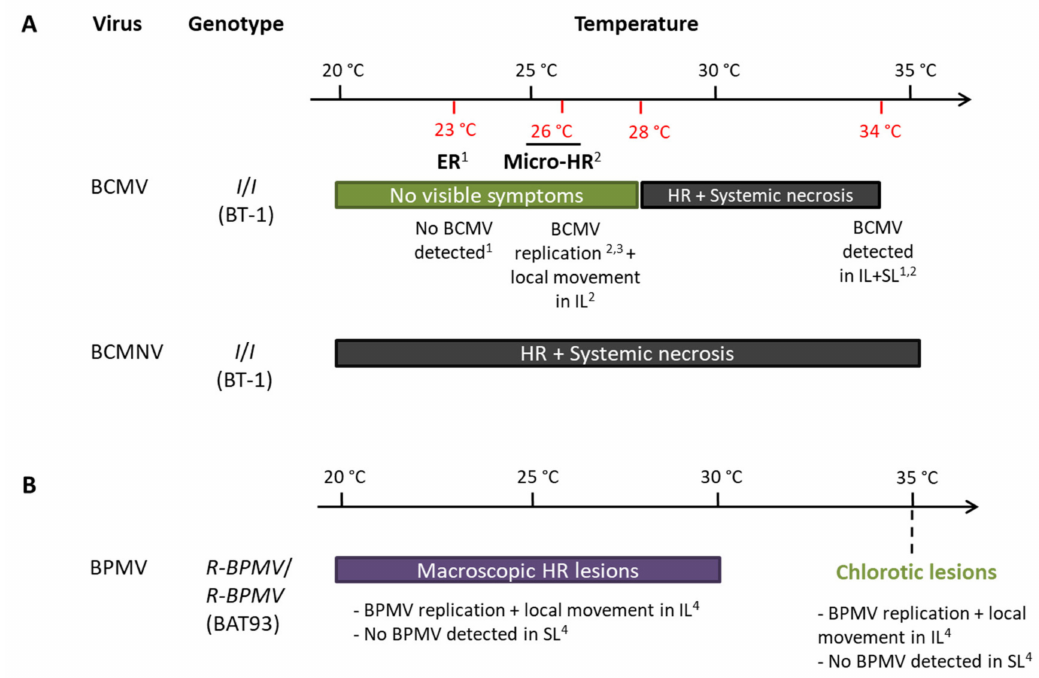
Figure 6. Resistance phenotypes of R-BPMV - and I -derived resistances do not share the same features regarding temperature: ( A )Potyviruses Bean common mosaic virus (BCMV) and Bean common mosaic necrosis virus (BCMNV); ( B )Comovirus Bean pod mottle virus (BPMV) Abreviations: ER: Extreme resistance, HR: Hypersensitive Reaction, IL: inoculated leaf, Micro- HR: microscopic Hypersensitive Reaction, SL: systemic leaf. References: 1: Collmer et al. 2000 (whole-plant study); 2: Cadle-Davidson and Jahn 2006 (whole-plant study); 3: Cadle-Davidson and Jahn 2005 (BCMV transfection in protoplasts); 4: this